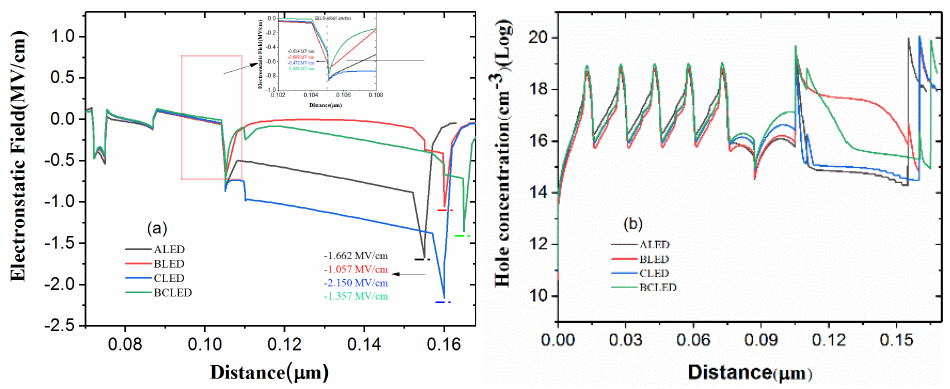
Figure 4. ( a ) Electrostatic field and ( b ) hole concentrations of the four structures at 400 mA.